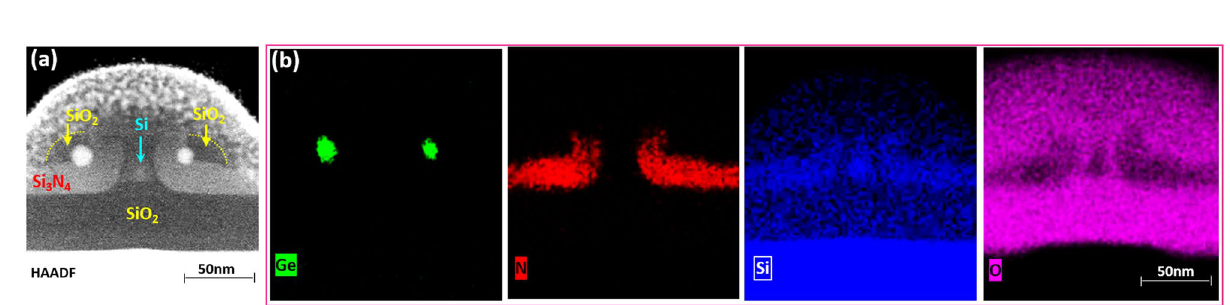
Figure 2. Transmission electron microscopy (TEM) observations following thermal oxidation of poly-SiGe spacer islands nano-patterned over Si 3 N 4 layers deposited over poly-Si ridges. ( a ) STEM micrograph, ( b ) EDX maps of elemental Ge, N, Si, and O of the paired Ge QDs, each with diameter of 12 nm, formed at each sidewall of the poly-Si